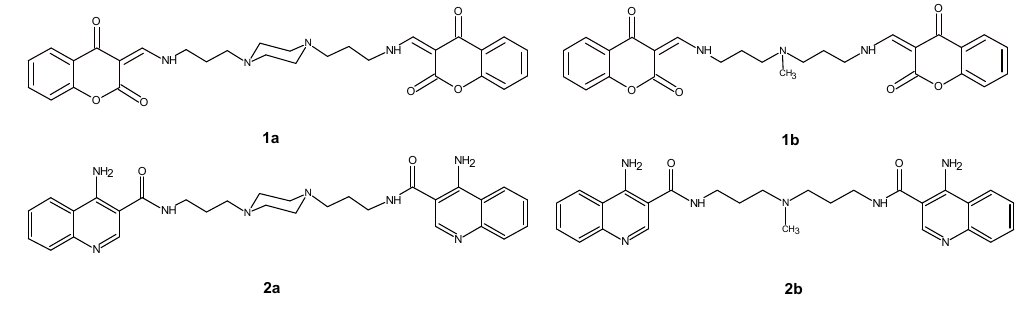
Figure 1. Chemical structure of examined compounds.